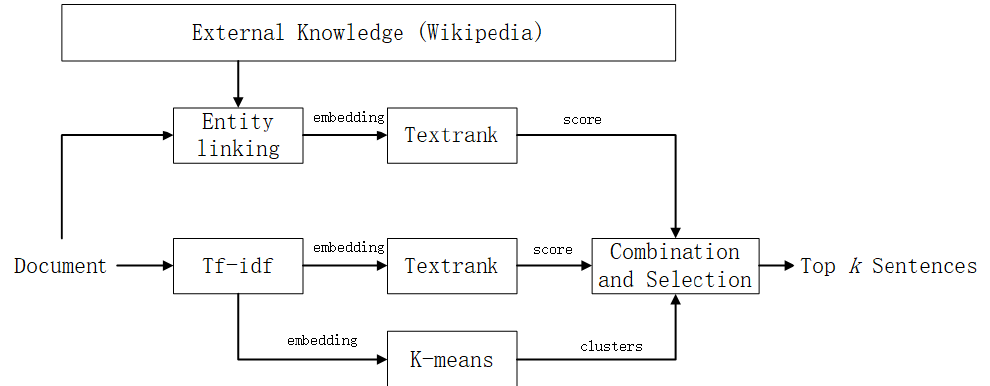
Figure 1. The overview of the Knowledge Graph-Based Summarizer with K-means and TextRank (kg-KMTR)